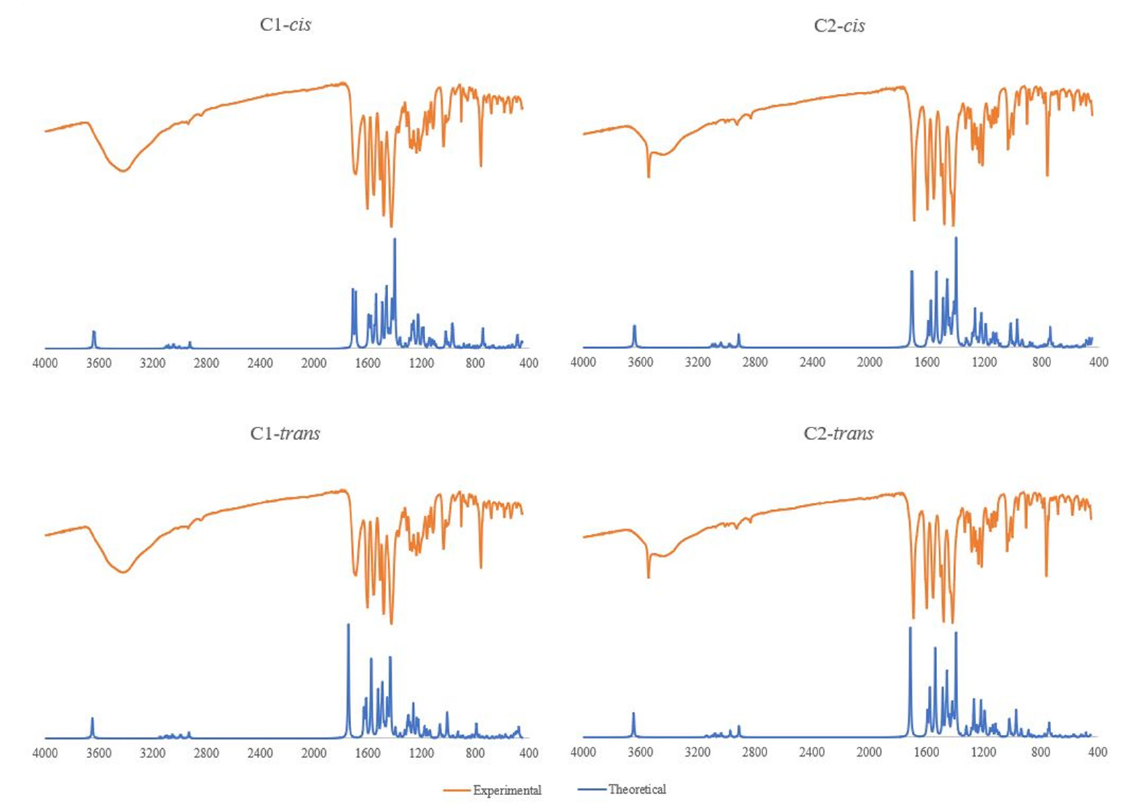
Figure 3. Experimental and theoretical IR spectra for C1 and C2.